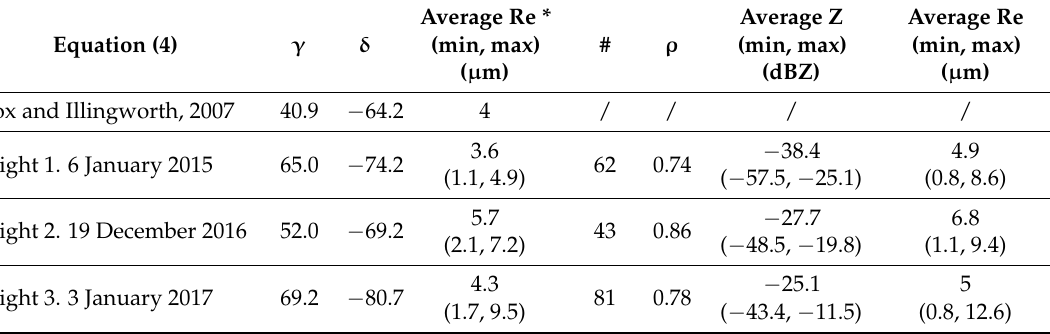
Table 4. Parametrical coefficient to optimize Equation (5) to derive Re with Z measured with the cloud radar and by the LOAC sensor along the tethered balloon flight.